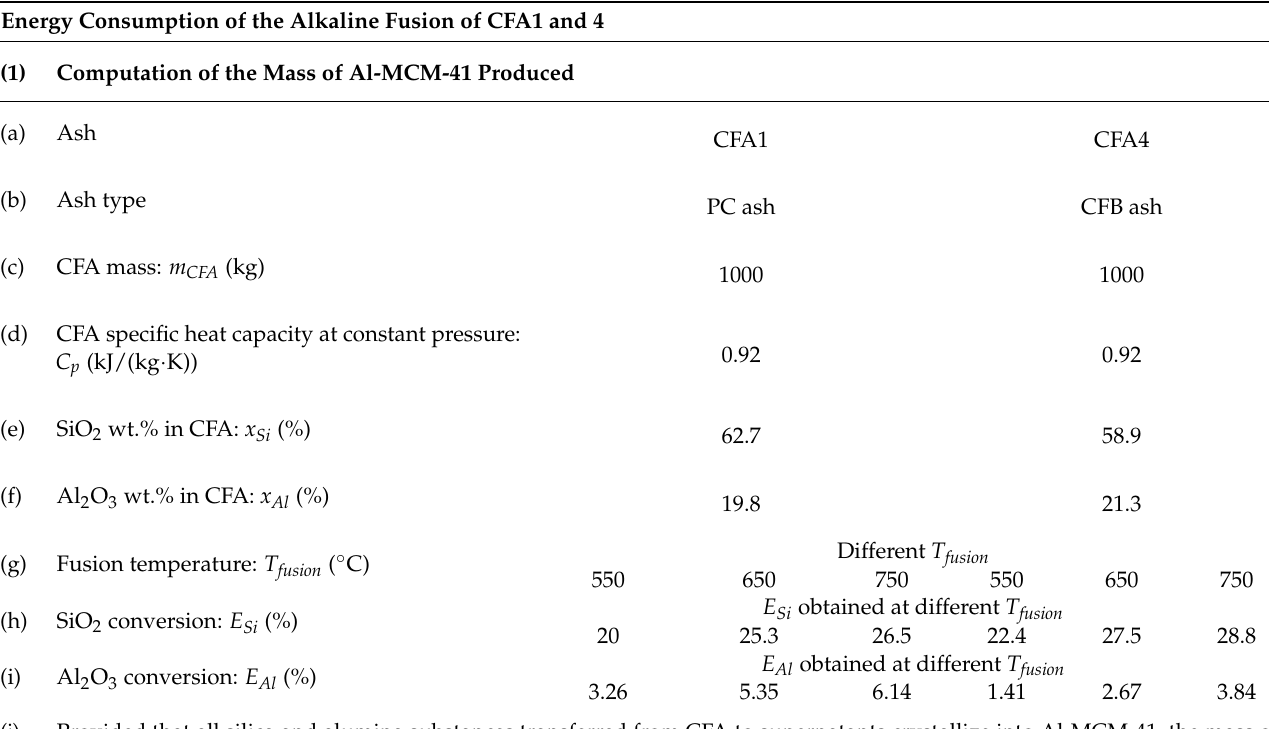
Table 3. Analysis of energy consumption per mass of Al-MCM-41 produced following alkaline fusion of CFA1 and 4. Energy Consumption of the Alkaline Fusion of CFA1 and